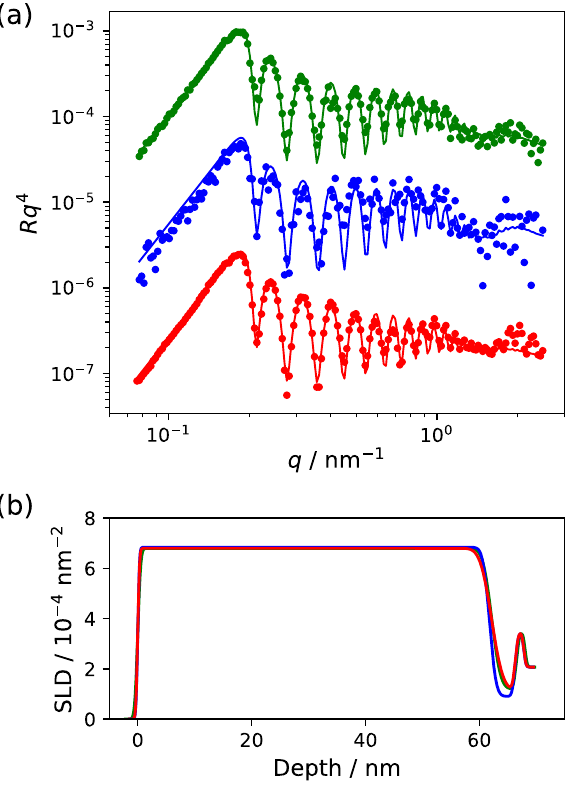
Figure 4. Neutron reflectivity profiles ( a ) and depth distribution of SLD obtained by the fitting analysis ( b ). The standard, low-count, and predicted data in each panel are colored in green, blue, and red, respectively. The circles and solid curves in ( a ) indicate the experimental data and fitted results, respectively. The reflectivity data are vertically shifted for visibility.